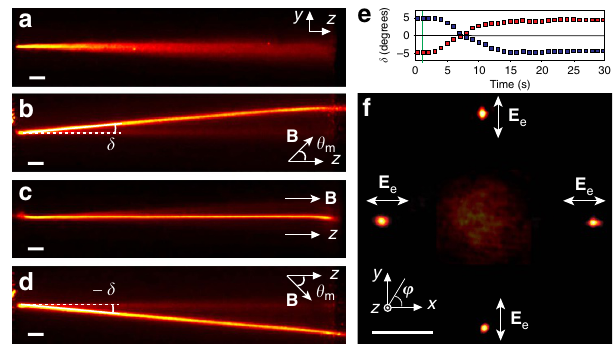
Figure 2 | Soliton steering in NLC by means of an external magnetic field. ( a ) Acquired images of an ordinary wave beam undergoing diffraction while propagating along the z axis, ( b – d ) projections of trajectories of extraordinary-wave self-confined solitons (visible because of weak out-of-plane light scattering) on the zy plane, from a circularly polarized beam of power P ¼ 7mW when B is oriented at a fixed polar angle y m ¼ 45 (cid:2) with respect to z and various azimuthal angles j : 90 (cid:2) ( b ), 0 (cid:2) , 180 (cid:2) ( c ) and 270 (cid:2) ( d ) with respect to x , respectively. ( e ) Time evolution of the beam walk-off in the plane yz when the orientation of the magnetic field ( B ¼ 0.2T) was abruptly ( o 1s) switched from the angular position y m ¼ 45 (cid:2) , j ¼ 90 (cid:2) to y m ¼ 45 (cid:2) , j ¼ 270 (cid:2) (red squares) and from y m ¼ 45 (cid:2) , j ¼ 270 (cid:2) to y m ¼ 45 (cid:2) , j ¼ 90 (cid:2) (blue squares), respectively. The vertical green line indicates when B was switched. ( f ) Intensity profiles of the output beam for various values of j . The broad spot in the centre corresponds to the diffracting ordinary-wave beam; the four narrow spots are the outputs of extraordinary-wave solitons, angularly displaced by the orientation of the magnetic field. Counterclockwise from right: j ¼ 0 (cid:2) , 90 (cid:2) , 180 (cid:2) and 270 (cid:2) , respectively. The white scale bars in a – d , f , 50 m